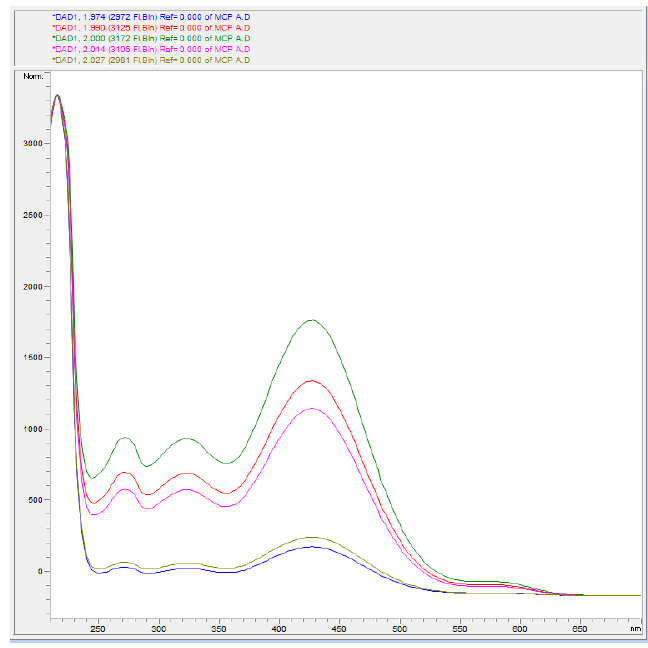
Figure 3. mCP absorption spectra recorded in range of λ = 250–650 nm .